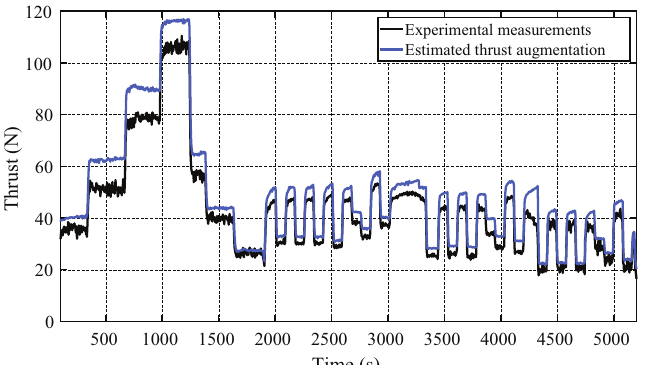
Figure 20. Estimations of the augmented thrust computed with the LADRC + LSC controlled nozzle exhaust gas speed.